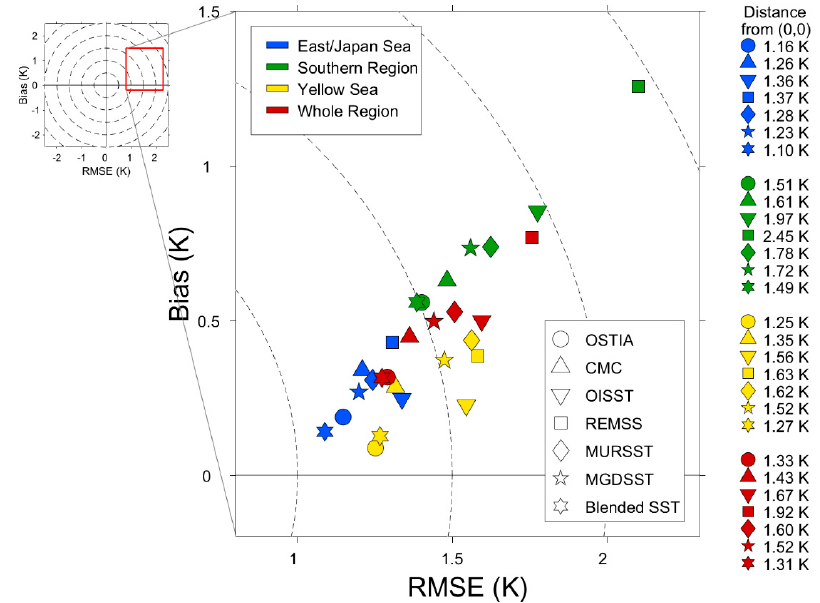
Figure 6. Scatter plot of root-mean-squared error (RMSE) and bias in sea surface temperature (SST) analyses in the East / Japan Sea, southern region of the Korean Peninsula, Yellow Sea, and for the region as a whole. Dashed contours represent the constant value of the distances from the zero bias and zero RMSE.